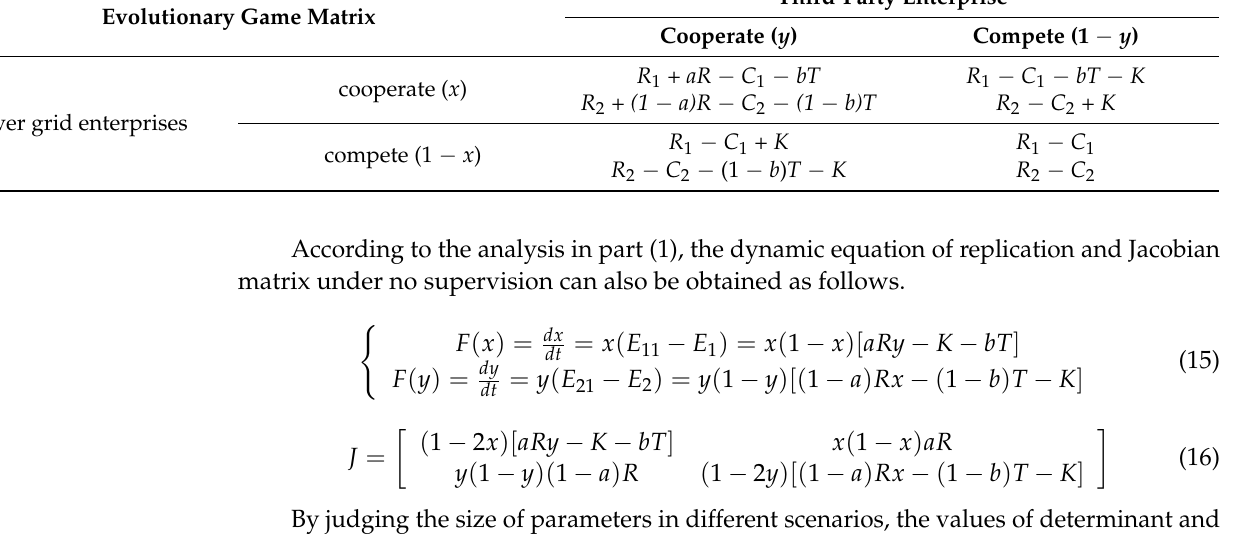
Table 5. The evolutionary game matrix of the two parties without government supervision. Third-Party Enterprise Evolutionary Game Matrix Cooperate ( y ) Compete (1 − y )